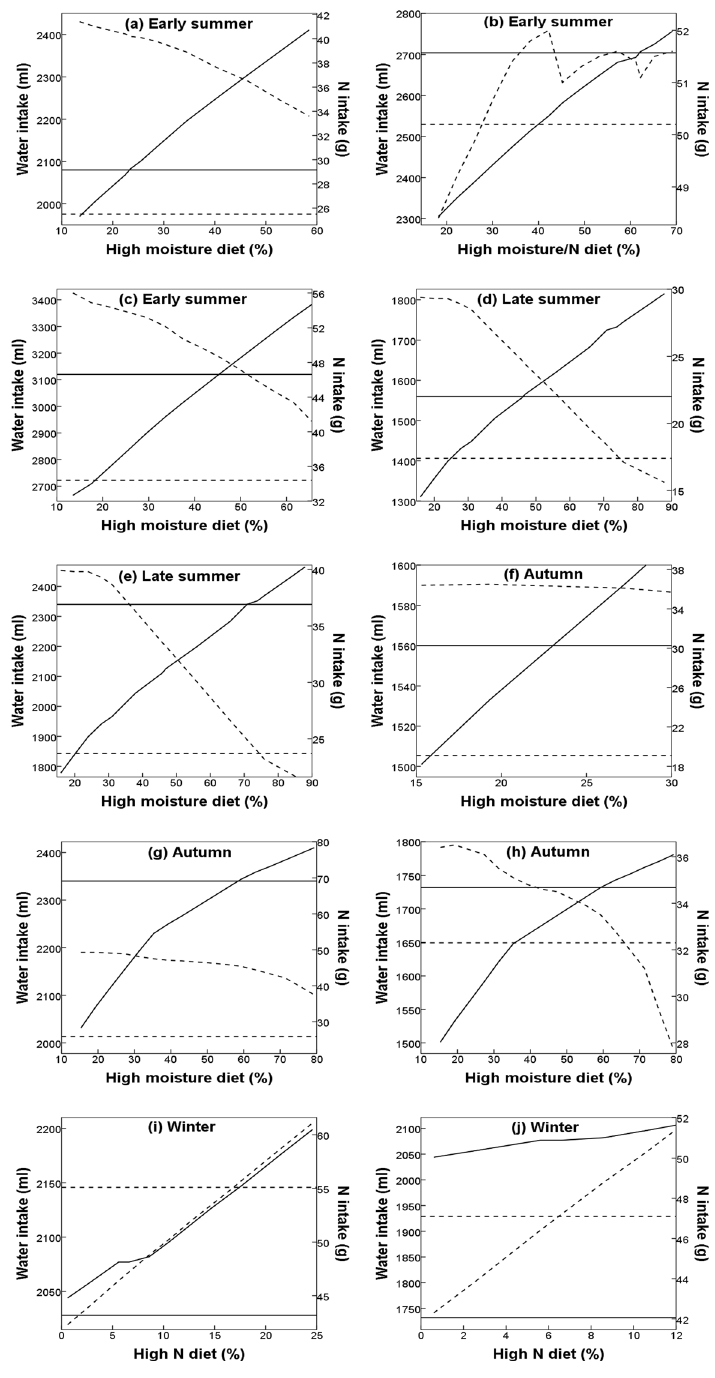
Fig 3. Seasonal water (ml; solid line) and nitrogen (N; g; dashed line) intake of desert bighorn sheep (DBS) under average precipitation for a) non-reproductive and early breeding females, b) late breeding females, and c) males, and under drought conditions for d) non-reproductive and reproductive females, e) males, f) early breeding females, g) non-reproductive and late breeding females, h) males, i) early breeding females, and j) late breeding females in response to shifts in diet in Cabeza Prieta National Wildlife Refuge, Arizona, USA. Panels f to j are calculated from forage moisture and N content in pretreatment under drought conditions, and DBS diet in treatment under above-average precipitation. The start of lines at the left represent observed diet proportions (i.e., without shifts). Horizontal lines represent DBS daily maintenance requirements for water (solid) and N (dashed), and thus intakes above these lines represent a positive